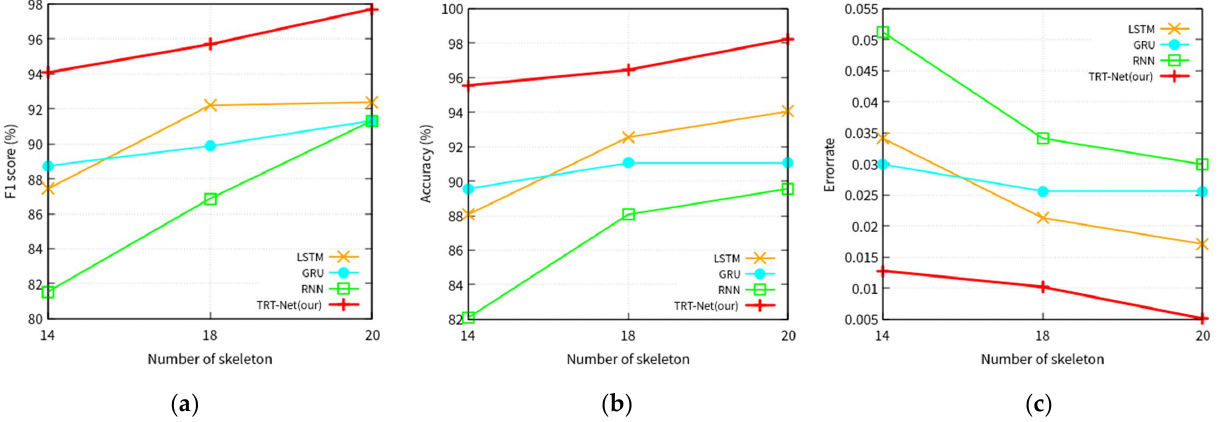
Figure 10. ( a ) F 1 score , ( b ) accuracy , and ( c ) error rate ( MSE ) according to the number of skeleton joints: Yao et al. [7], 14 skeleton joints; Kearny et al. [5], 18 skeleton joints; and our method, 20 skeleton joints. Table 6. Body and face joints detected for each dog